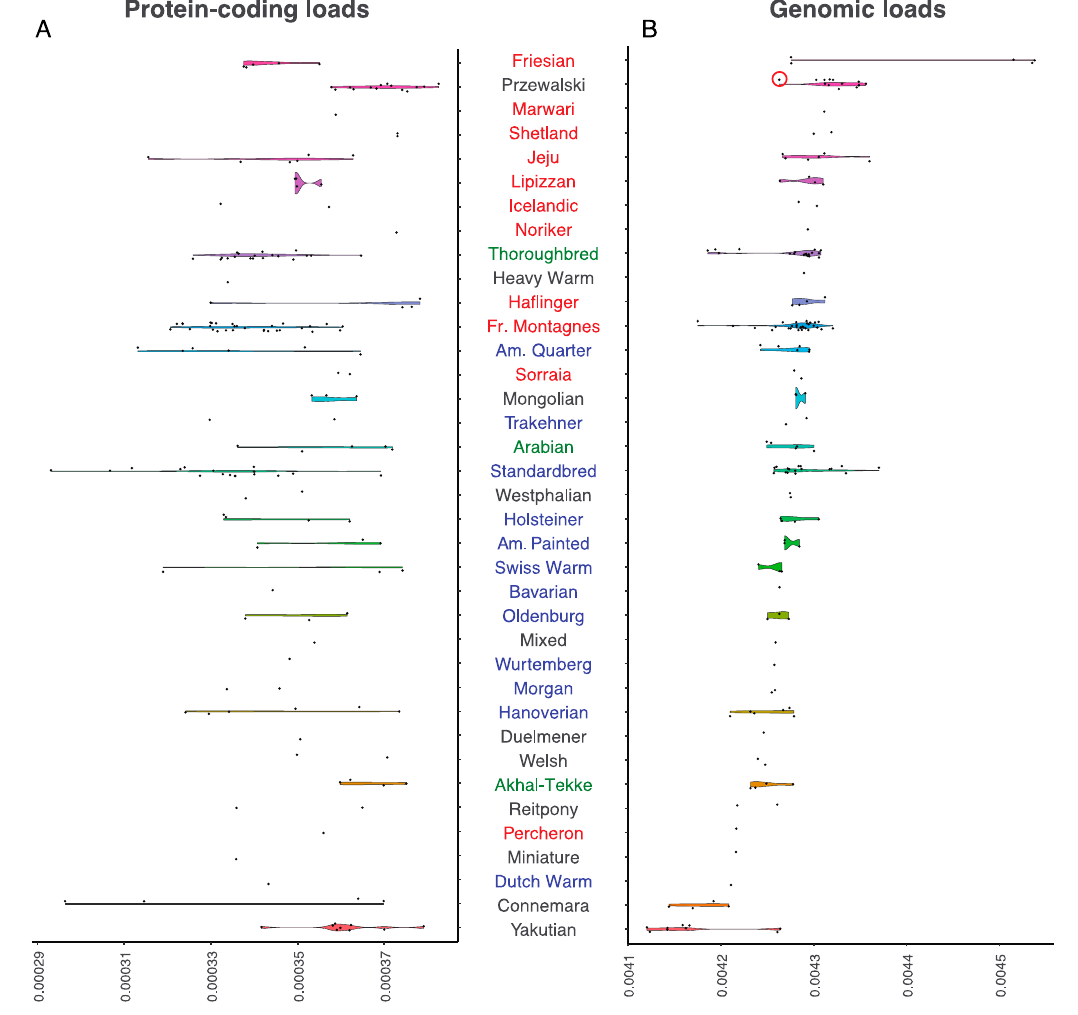
Figure 1. Mutational loads per breed, based on positions with a phyloP score greater than 1.5: ( a ) Loads were estimated from protein-coding sites ( a ) or genome-wide ( b ). Names are color-coded for working horses (red), leisure horses (blue), and hotblood lines (green). Breeds considered of uncertain assignation are shown in grey. The red circle shows the F1 hybrid between a Przewalski and a domestic horse.